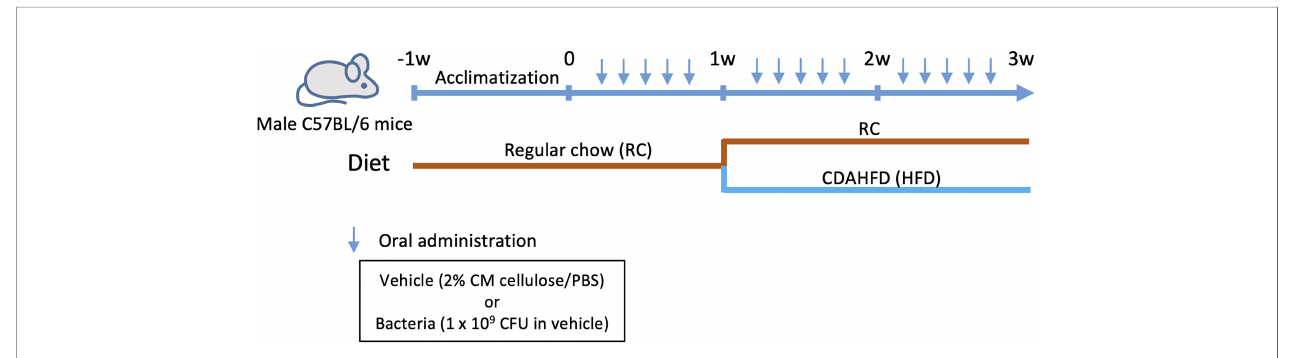
FIGURE 1 | Flowchart depicting the experimental work fl